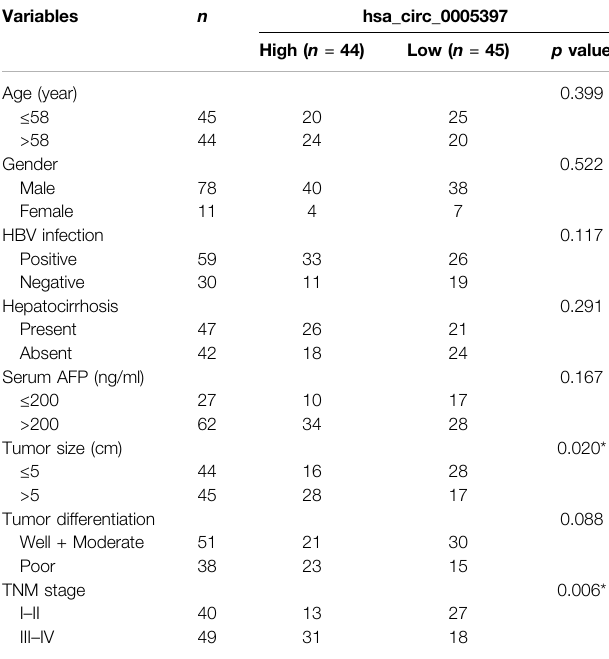
TABLE 2 | Association of plasma hsa_circ_0005397 with clinicopathologic characteristics of HCC patients. Variables